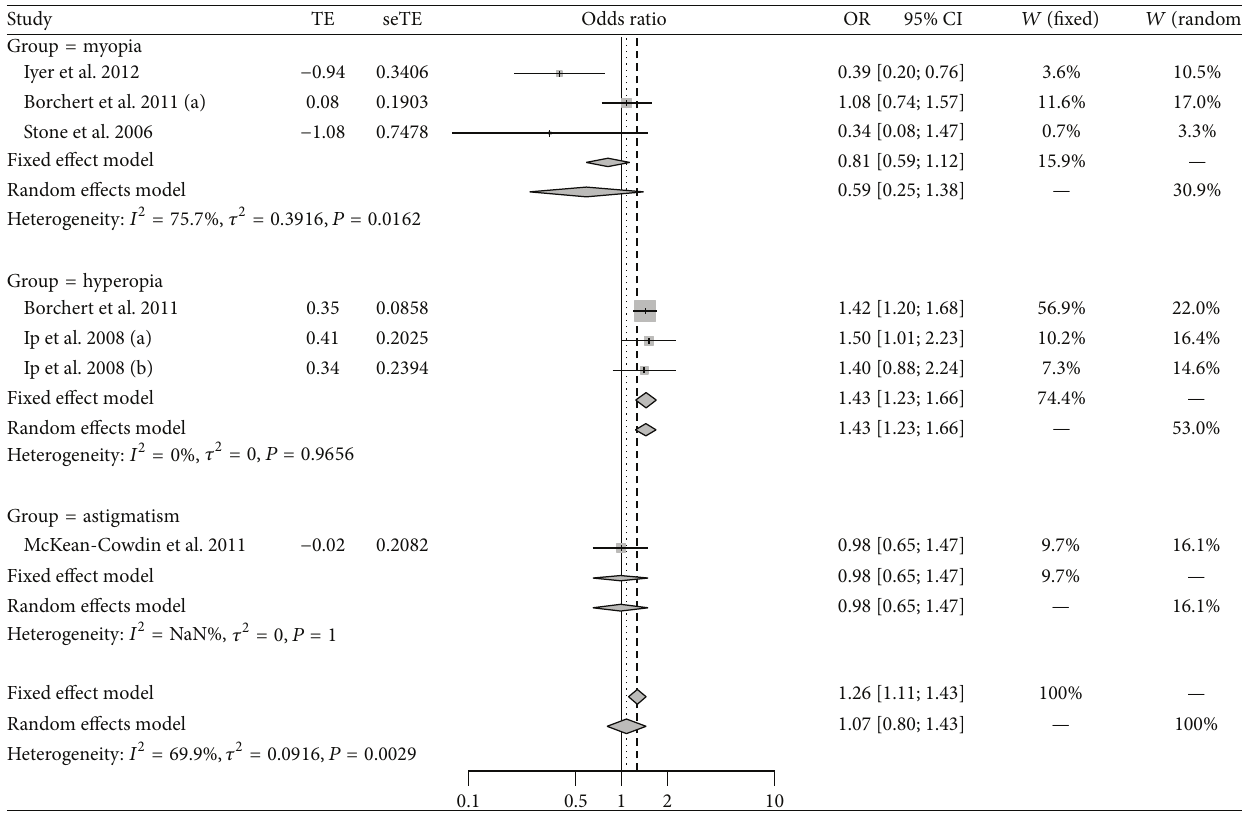
Figure 2: Meta-analysis for association of maternal smoking with childhood refractive error.